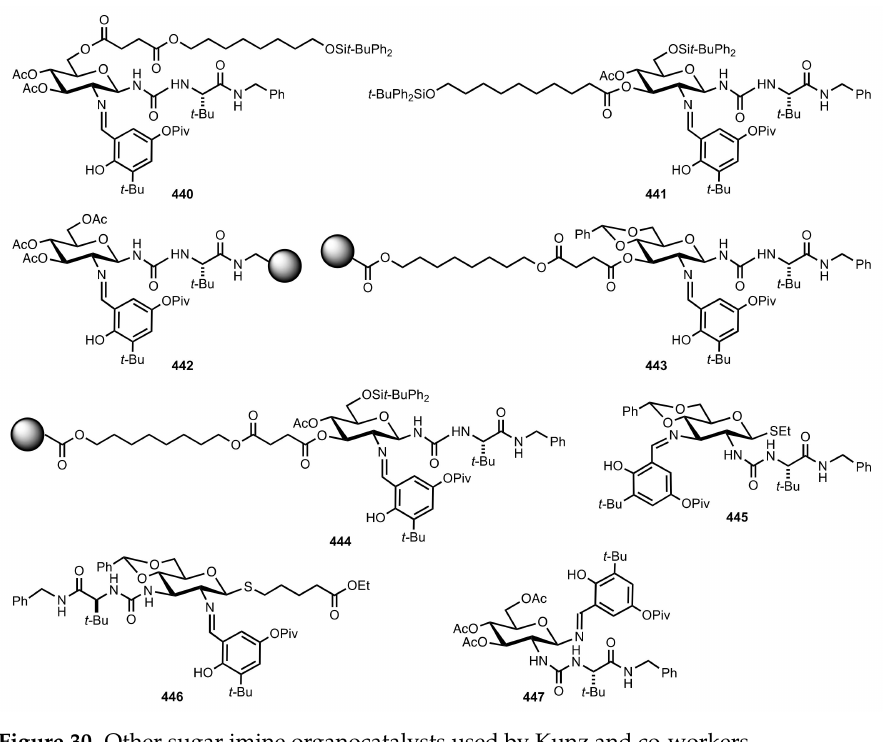
Figure 30. Other sugar imine organocatalysts used by Kunz and co-workers.